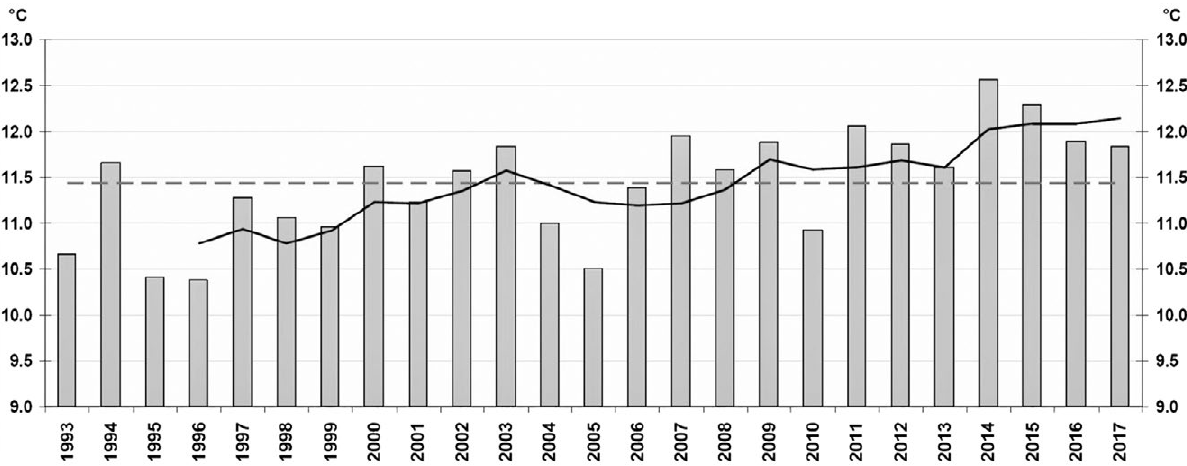
Fig. 7. – Veneto district mean air temperatures. Weighted averages of 134 thermometric stations operating in Veneto for the period 1993- 2017. The solid line represents the four-year moving average. The dashed line represents the mean for the entire period (from Dell’Acqua et al. 2017,